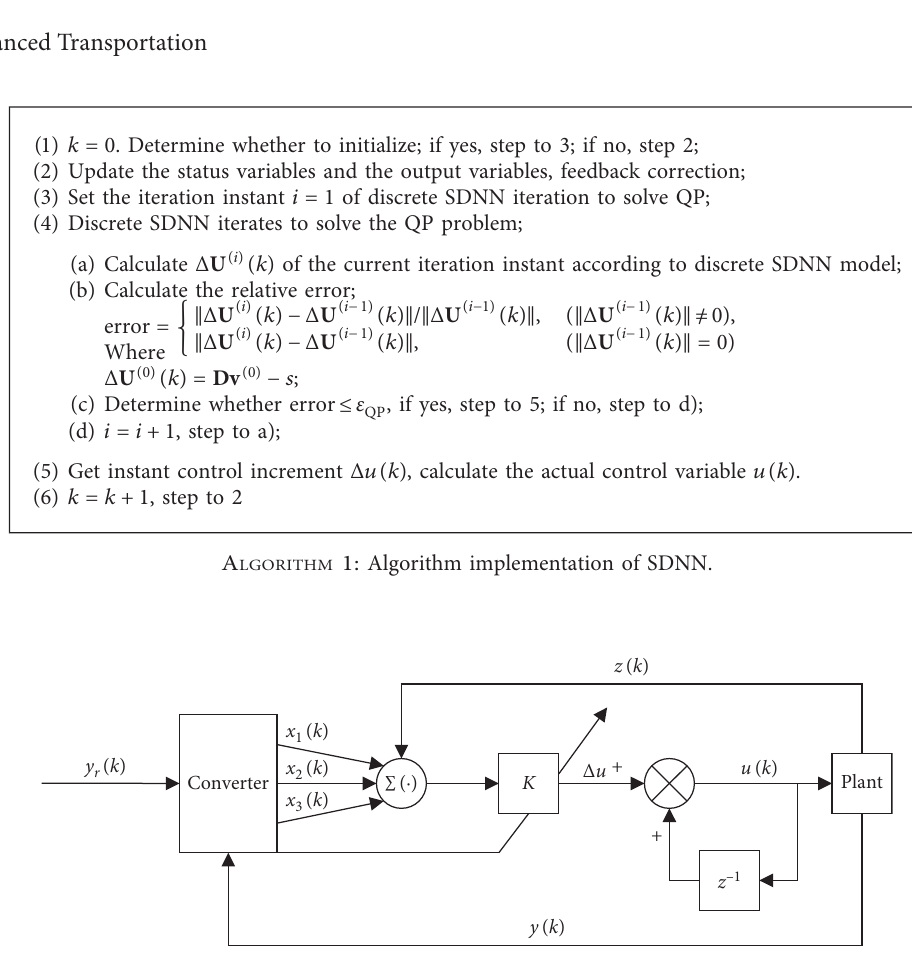
Figure 7: Structure block diagram of the PID controller based on SN.